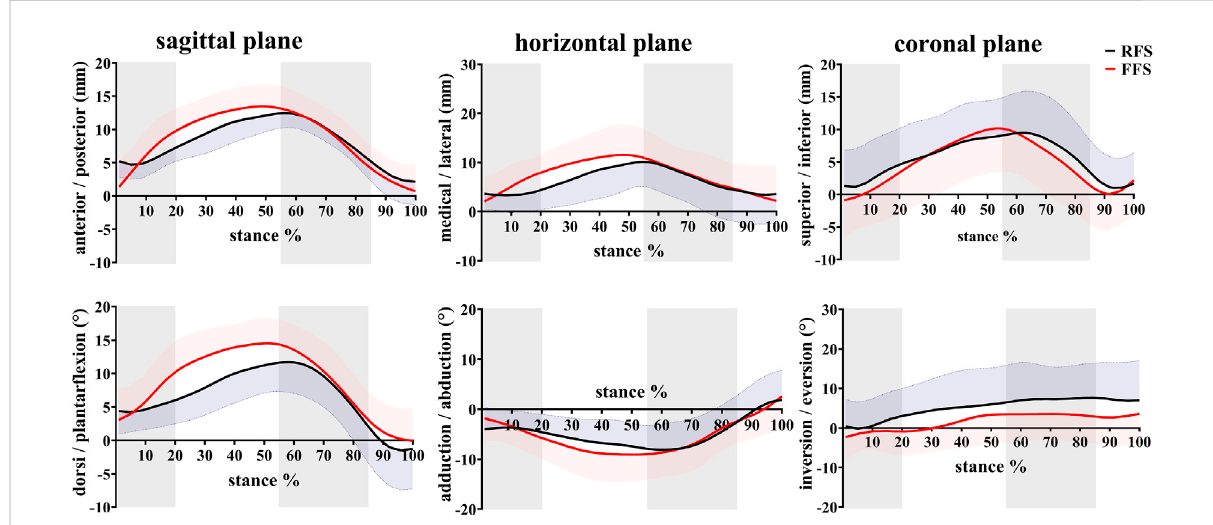
FIGURE 5 Effects of different foot strike patterns on the in vivo kinematics data of MLA during the stance phase of running. Note: RFS, rearfoot strike pattern and FFS, forefoot strike